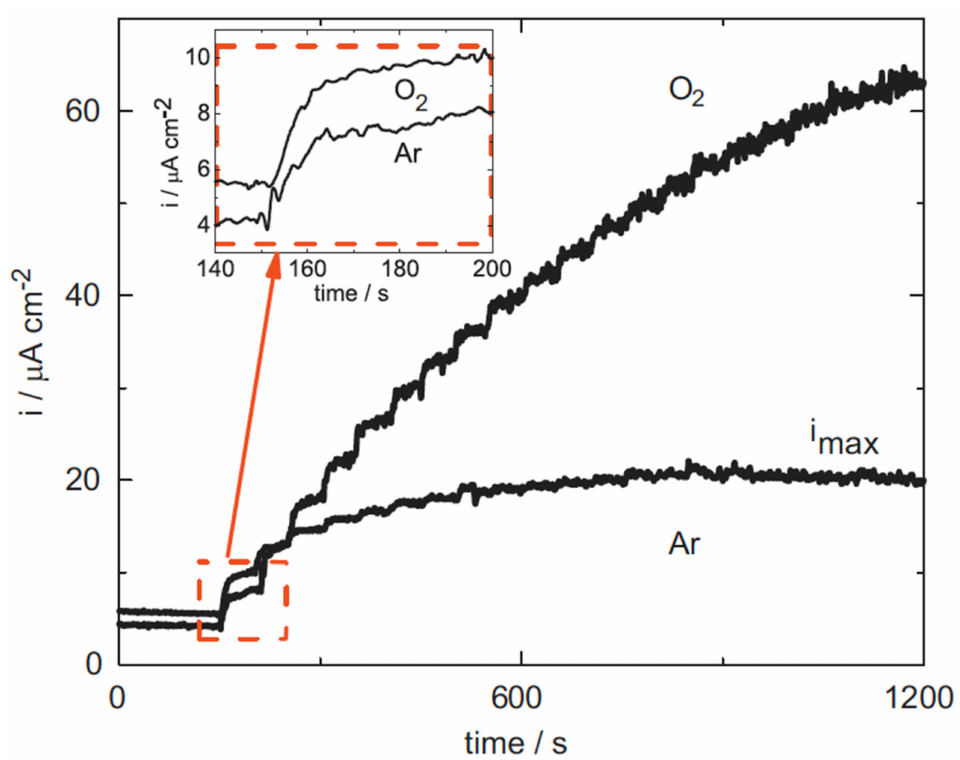
Figure 1. Glucose chronoamperometric response in anaerobic and aerobic condition on IrO x /Nafion/GO x at 1.2 V. Inset shows the first glucose aliquot added into the solution. Reprinted with permission from reference [13]. Copyright 2010 Elsevier